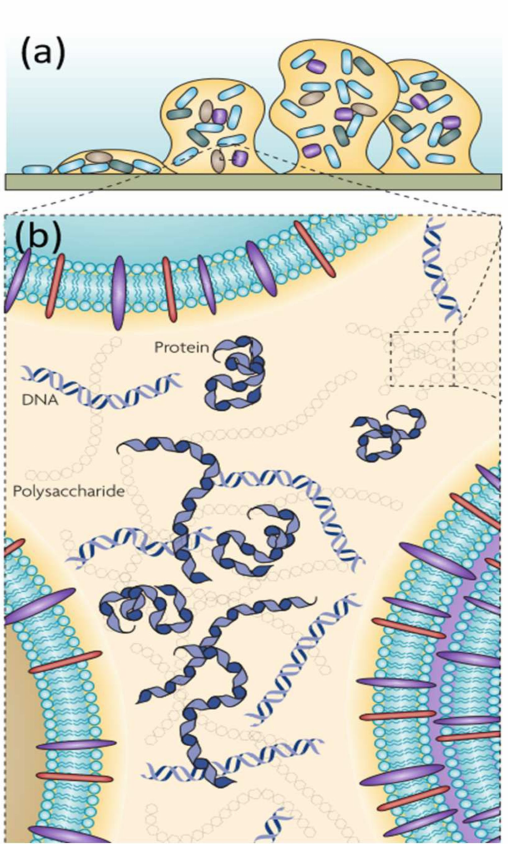
Figure 1. ( a ) The model of a bacterial biofilm attached to a solid surface; biofilm formation begins if bacteria attach to a solid surface and then divide to form microcolonies and produce EPS. Due to bacterial division and EPS formation, different kinds of microorganisms are attracted to enter the consortia/film, and a mature biofilm is gradually formed; ( b ) The major matrix components (polysaccharides, proteins, lipids, and nucleic acid) are mainly distributed between cells, and there are differences in different regions of EPS. Images are from [3]. Reproduced with permission from Springer